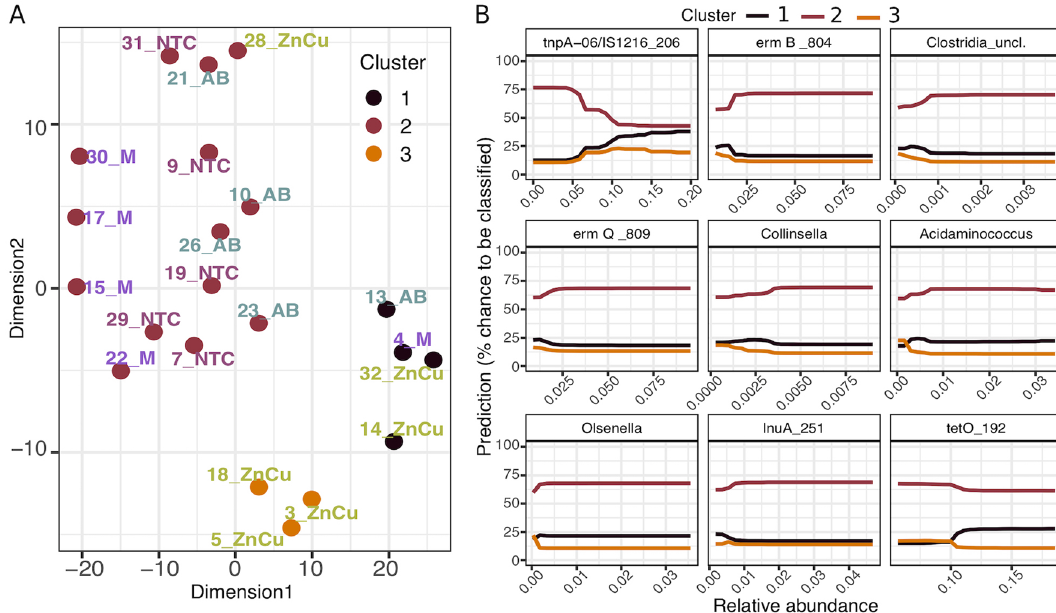
Figure 5. t-SNE analysis of a dataset containing ARGs, MGEs and TSS normalized OTUs (all relative abundances). ( A ) The clustering pattern of the samples. ( B ) Partial dependence plot of cluster numbers and